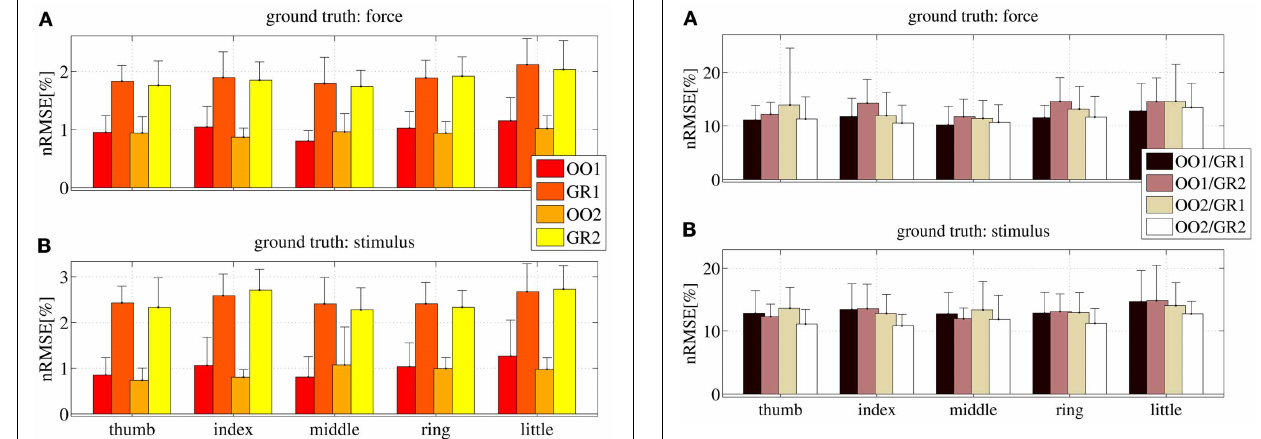
FIGURE 9 | Normalized root-mean-square error obtained by the linear prediction of force (A) and visual stimulus (B) for all subjects, for each session (OO1, GR1, OO2 and GR2) and for each finger. Each bar and stem represents the mean nRMSE and one standard deviation obtained over all subjects.